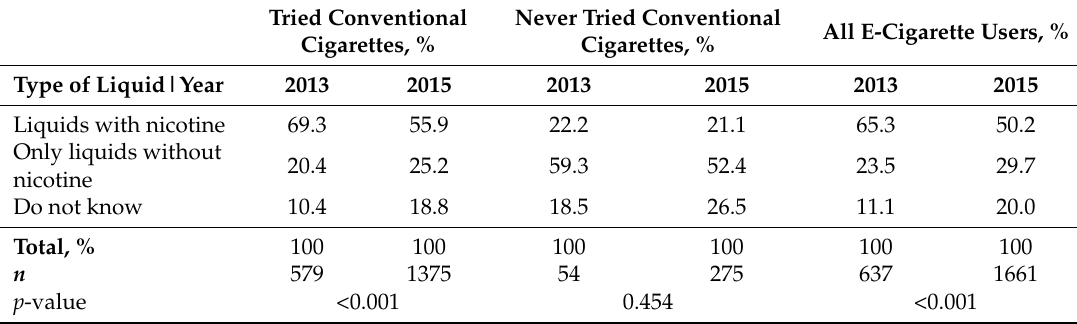
Table 2. Distribution of e-cigarette liquids among all e-cigarette users and among those e-cigarette users who had tried and those who had never tried conventional cigarettes in 2013 and 2015, %. Tried Conventional Never Tried Conventional All E-Cigarette Users, % Cigarettes, % Cigarettes, % Type of Liquid|Year